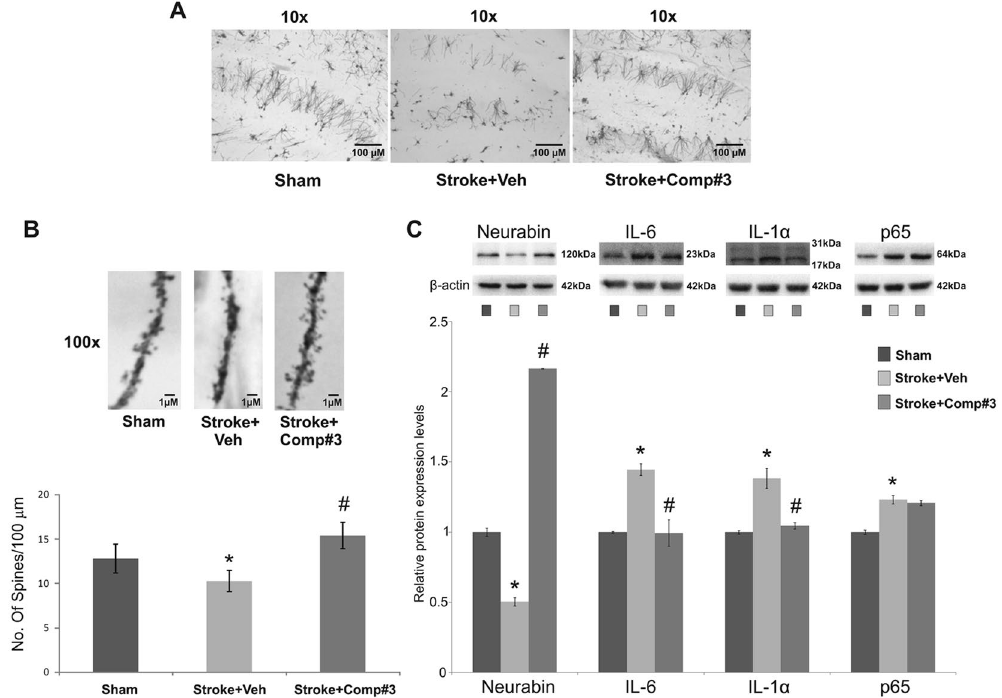
Figure 4. ( A,B ) Photomicrographs and the respective bar graph showing spine density in sham, vehicle and #3 treated group after BCCAo at 10x and 100x magnification. The compound #3 treated group showed protection again spine loss following BCCAo. ( C ) Showing immunoblot of neurabin, IL1 α , IL6 and p65 (inflammatory markers) protein expression in the hippocampus. Lanes were loaded with 30 μ g of protein. Expression was compared using densitometry. Densitometry results represent markers: β -actin ratios. Values are represented as mean ± SE with n = 3; p ≤ 0.05 indicates significant post hoc differences between sham vs vehicle group represented by ( * ) and vehicle vs #3 treated group, while represented by ( # ) by two-tailed student’s t-test. (n =